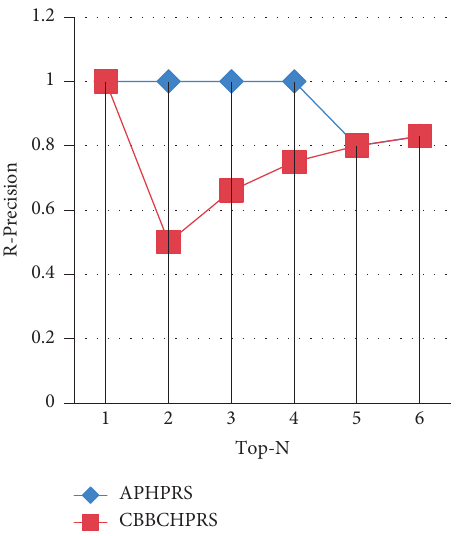
Figure 4: R -precision for the two recommender systems for dataset 1.